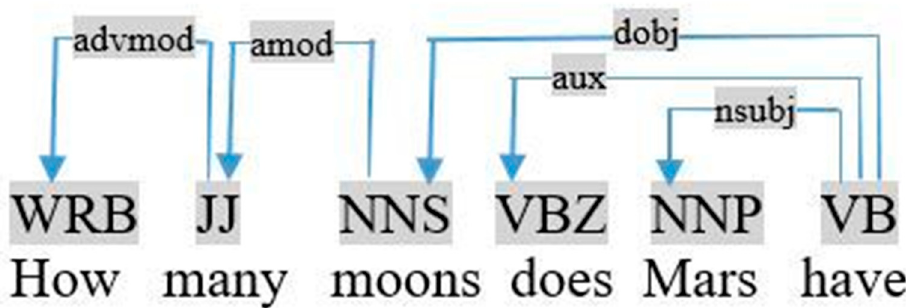
Figure 3. Graph dependency of the query «how many moons does Mars have».